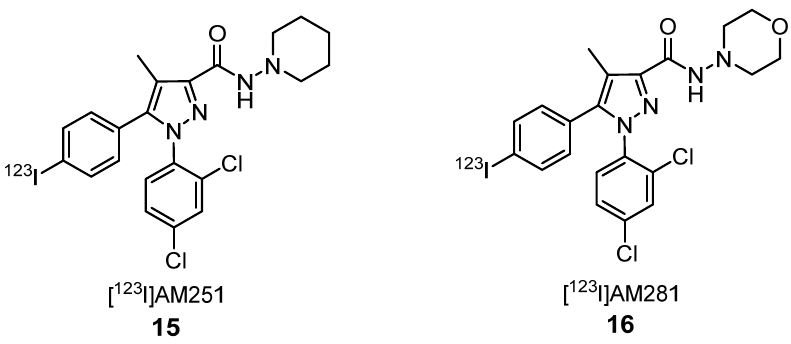
Figure 4. Structure of rimonabant ( 8 ) and structurally related [ 18 F]pyrazole PET tracers 9 – 14 [37,39,41–44].